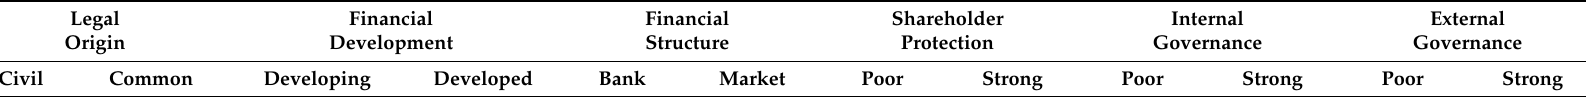
Table 8. The impact of institutions and financial development on target